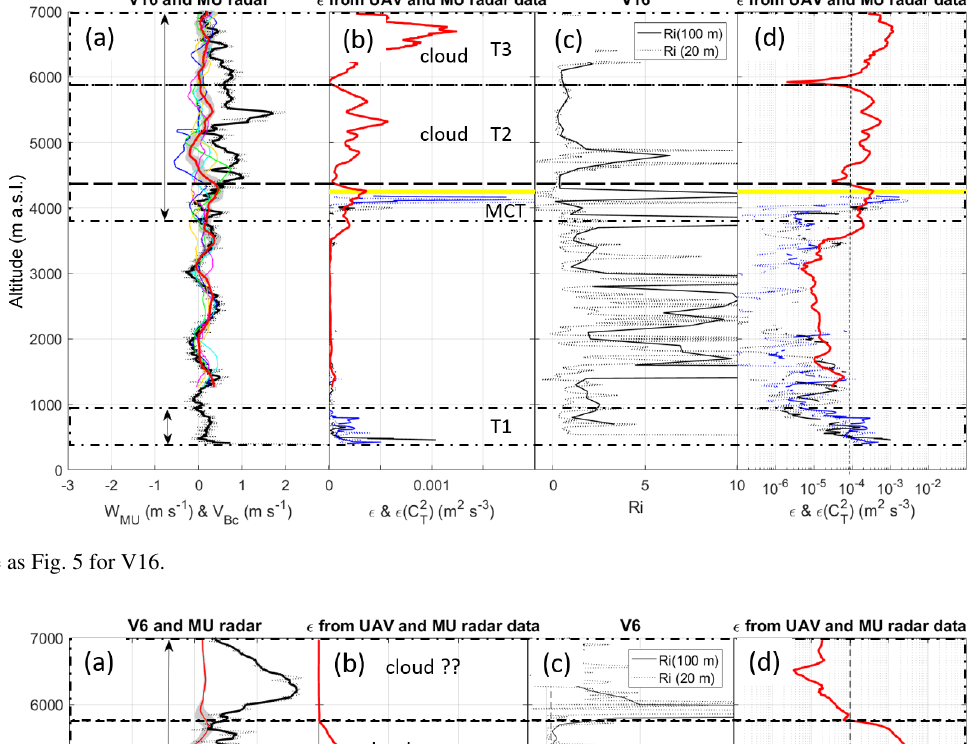
Figure 6. Same as Fig. 5 for V16.